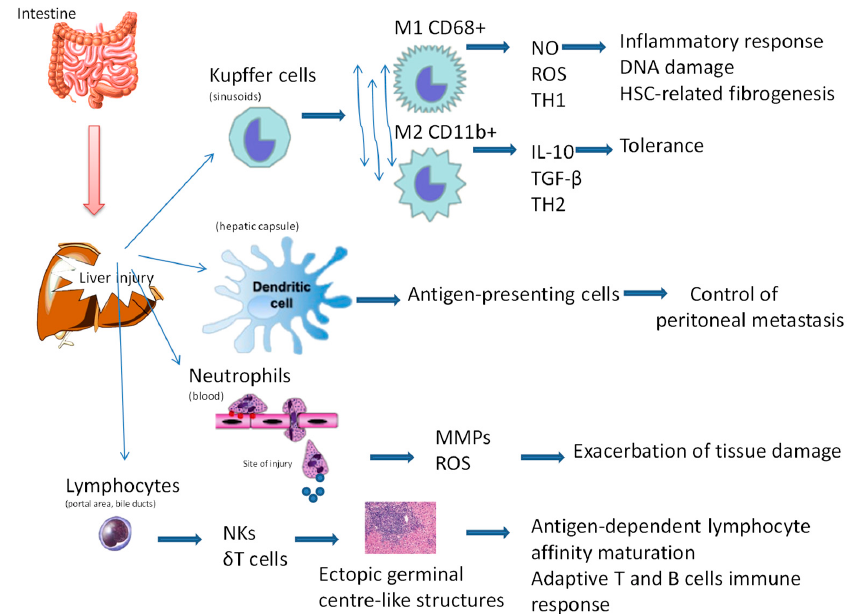
Figure 3. Schematic of the liver harbouring various immune cell populations with different functions. Kupffer cells near or inside the sinusoids decrease immune reactions by releasing cytokines; if these cytokines promote inflammation, the Kupffer cells are acting as M1 macrophages; if the cytokines decrease inflammation and promote tissue repair, the cells are M2 macrophages. Dendritic cells, the main antigen-presenting cells of the immune system, are mostly present in the subcapsular space. The capsule is in contact with the viscera and peritoneum, and thus is a barrier for pathogens and neoplastic cells arriving from these sites. Neutrophils, the most abundant cell type in the blood, accumulate at sites of injury and release matrix metalloproteinases (MMPs) and reactive oxygen species (ROS), exacerbating tissue damage. Lymphocytes in the blood and bile are involved in innate and adaptive immunity and are related in the formation of ectopic germinal centre-like structures in the liver during certain pathological situations (e.g., hepatitis C virus infection). NK (natural killer) cells, natural killer cells; γδ T cells, gamma delta T cells that have a distinctive T cell receptor (TCR) composed of γδ .